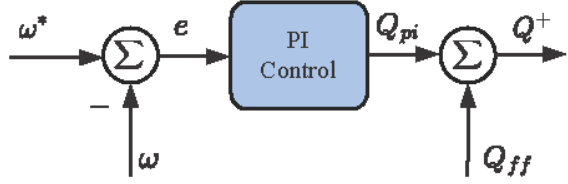
Figure 6. Frequency control is proposed at SIPQC. 𝑄 (cid:3033)(cid:3033) is the initial value for reactive